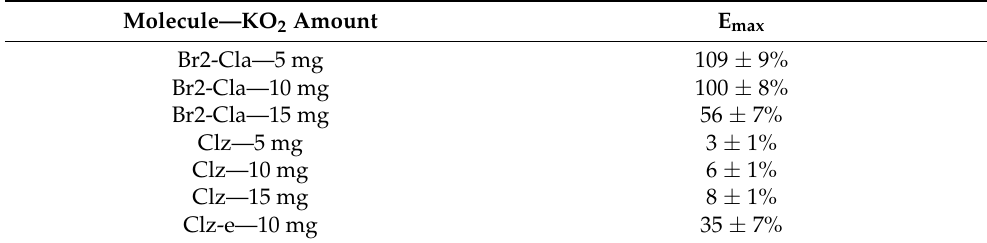
Table 4. Light-emission maximum (E max , in RLU) for the CL reactions of Br2-Cla, Clz and Clz-e at different concentrations of potassium superoxide (KO 2 ) (5–15 mg). Measurements were performed in aqueous solutions with a final concentration of the compounds of 3 µ M. Values are presented in percentage (%), with the results for Br2-Cla—10 mg as